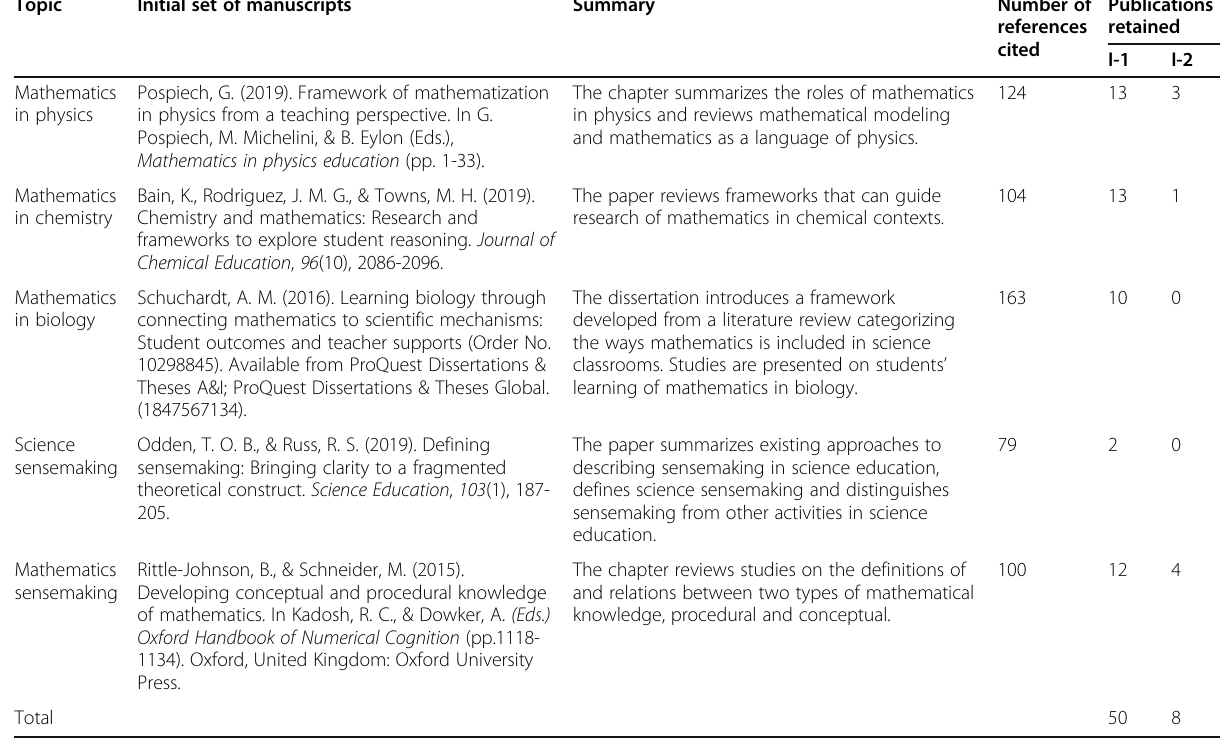
Table 1 Initial set manuscripts and number of publications retained after Iteration 1(I-1) and 2(I-2)